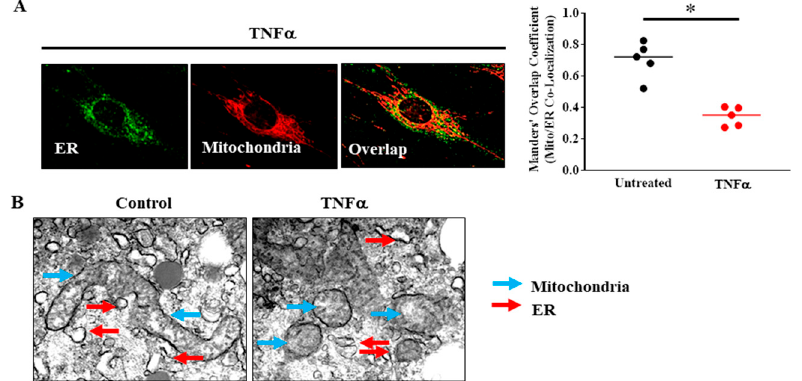
Figure 5. ( A ) In human ASM cells, ER was labeled using BODIPY FL thapsigargin (endoplasmic reticulum Ca 2+ pumps, green) and mitochondria were labeled using MitoTracker red and imaged in 3D by confocal microscopy. Proximity of mitochondria to the ER was determined by measuring the Manders’ overlap co-efficient. Acute TNF α exposure (20 ng/mL, 24 h) reduced proximity of mitochondria to the ER (* denotes a significant difference between TNF α treated and untreated control groups; p < 0.05; t -test; cells were dissociated from ASM samples from n = 5 patients and divided into TNF α treated and untreated control groups). ( B ) 3D EM images showing that mitochondria (blue arrows) in human ASM cells are fragmented after TNF α (20 ng/mL, 24 h) exposure and that the incidence of close proximity of mitochondria to ER (red arrows) was reduced (cells were dissociated from ASM samples from n = 2 patients and divided into TNF α treated and untreated control groups). All data are presented as scatter plots with lines indicating the mean. These figures are modified from presentations of previously reported results [13].